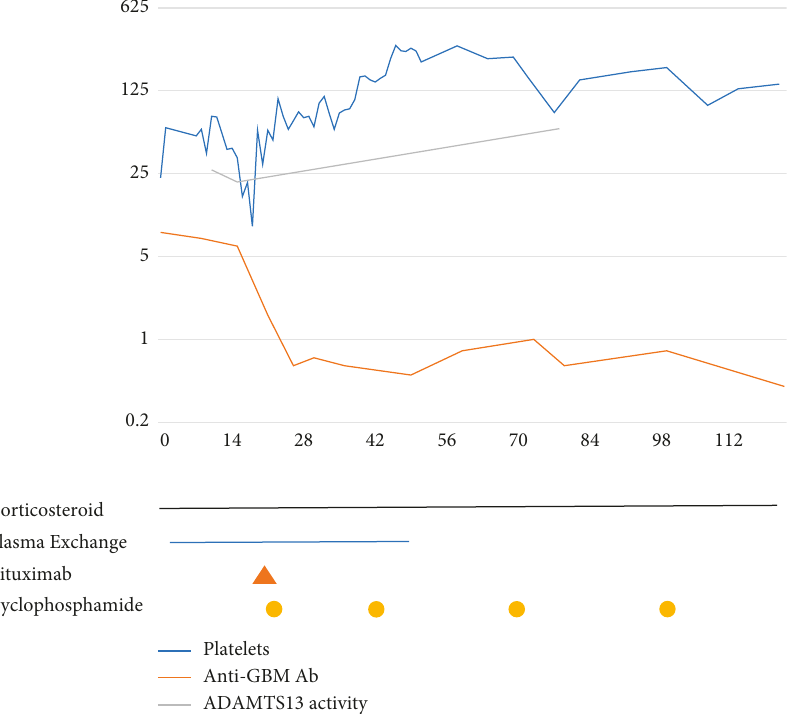
Figure 2: Logarithmic graph demonstrating platelet levels, anti-GBM antibody levels, ADAMTS13 activity alongside immunosuppressive therapy.